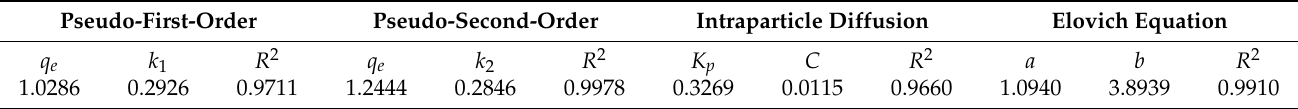
Figure 8. Plots of the pseudo-first-order model ( a ), pseudo-second-order model ( b ), intraparticle diffusion model ( c ), and elovich equation ( d ). Table 1. Kinetic parameters for copper ion adsorption on the prepared hydrogel.